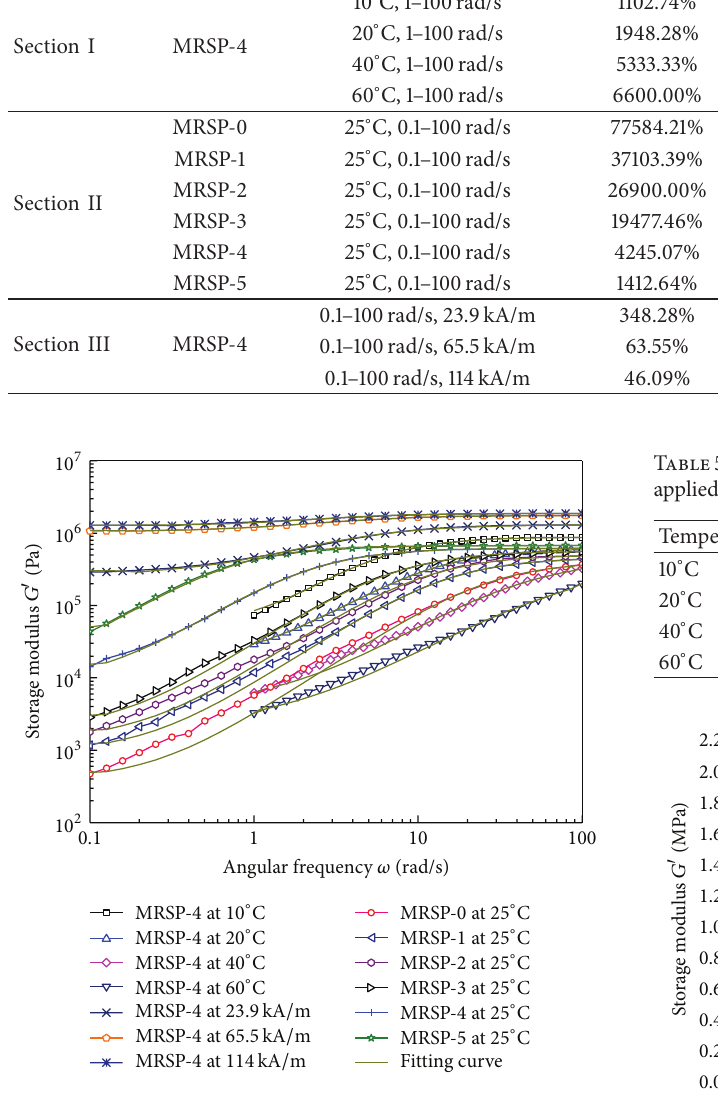
Figure 7: Fitting curves of all the experimental data.